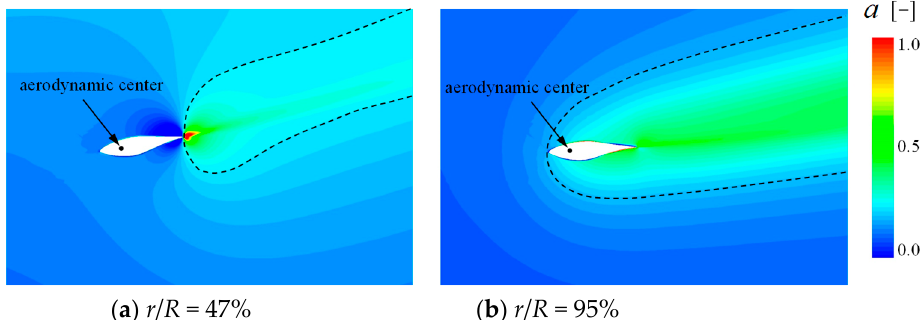
of r / R = 95% ( V ∞ = 7m/s, ω = 72rpm).